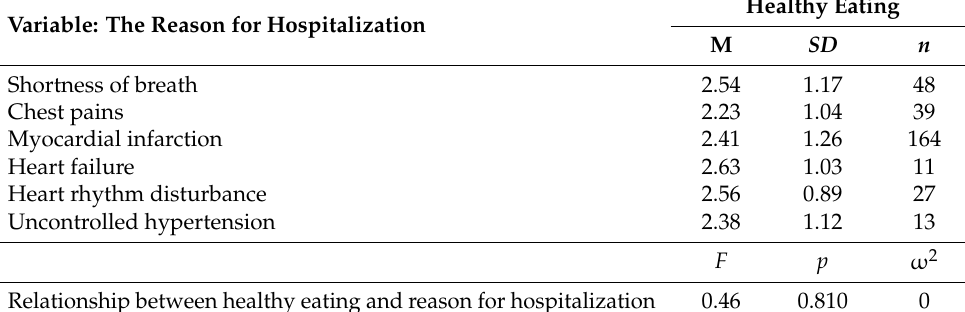
Table 7. Association of healthy eating with the reason for hospitalization. Variable: The Reason for